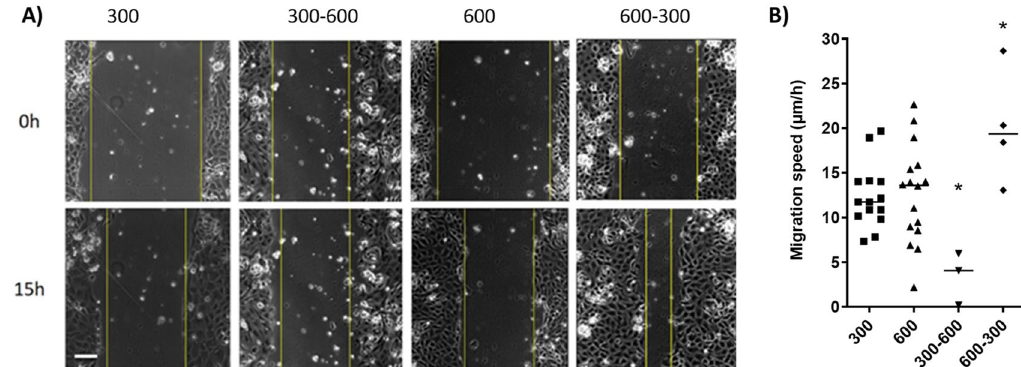
Figure 4. Primary cultured IMCD cells show a collective cell migration behavior. ( A ) Wound healing assays were performed with IMCD-cells that were cultivated at 300 or 600 mosmol/kg and in cells where the osmolality was acutely increased from 300 to 600 mosmol/kg (300–600) or decreased from 600 to 300 mosmol/kg (600– 300). A scratch was induced using a pipette tip. The migration was observed for 15 h. During migration the cells were cultivated in DMEM without serum. ( B ) The sum of the migration speed from both migration fronts was calculated and is presented as mean µm/h ± SEM. Statistically significant differences are marked by *. ANOVA, p < 0.05, n ≥ 14 (for 300 and 600) and n = 3 for 300–600 and n = 4 for 600–300. Scale bar 150 µm.